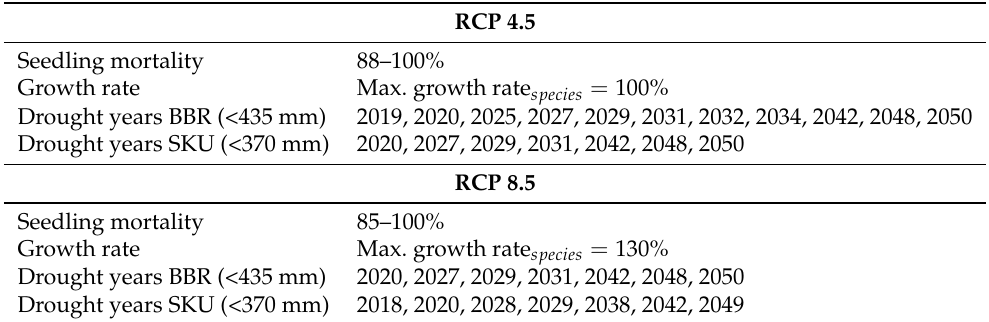
Table 5. IPCC Scenarios (RCP 4.5 and RCP